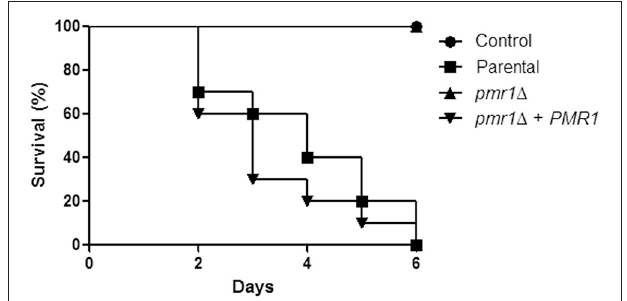
FIGURE 10 | The C. guilliermondii pmr1 1 null mutant displays virulence attenuation in the G. mellonella model. Inocula containing 2 × 10 7 yeast cells were injected directly into the hemocoel of G. mellonella larvae and survival was monitored daily. Experiments were performed three times, with a total of 30 larvae per group (10 larvae for each experiment). Control, PBS-injected group. The strains used are: KU141 (Parental), HMY134 ( pmr1 1 ), and HMY138 ( pmr1 1 + PMR1 ). No significant differences were observed between the mortality associated to parental and pmr1 1 + PMR1 strains ( P = 0.32). The pmr1 1 null mutant strain showed a significant difference in the ability to kill larvae when compared to the parental or re-integrant control strains ( P < 0.05 in both cases).